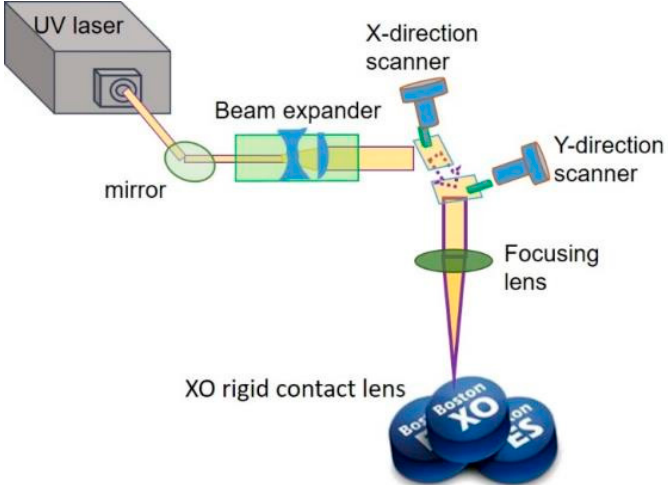
® rigid gas permeable (RGP) contact